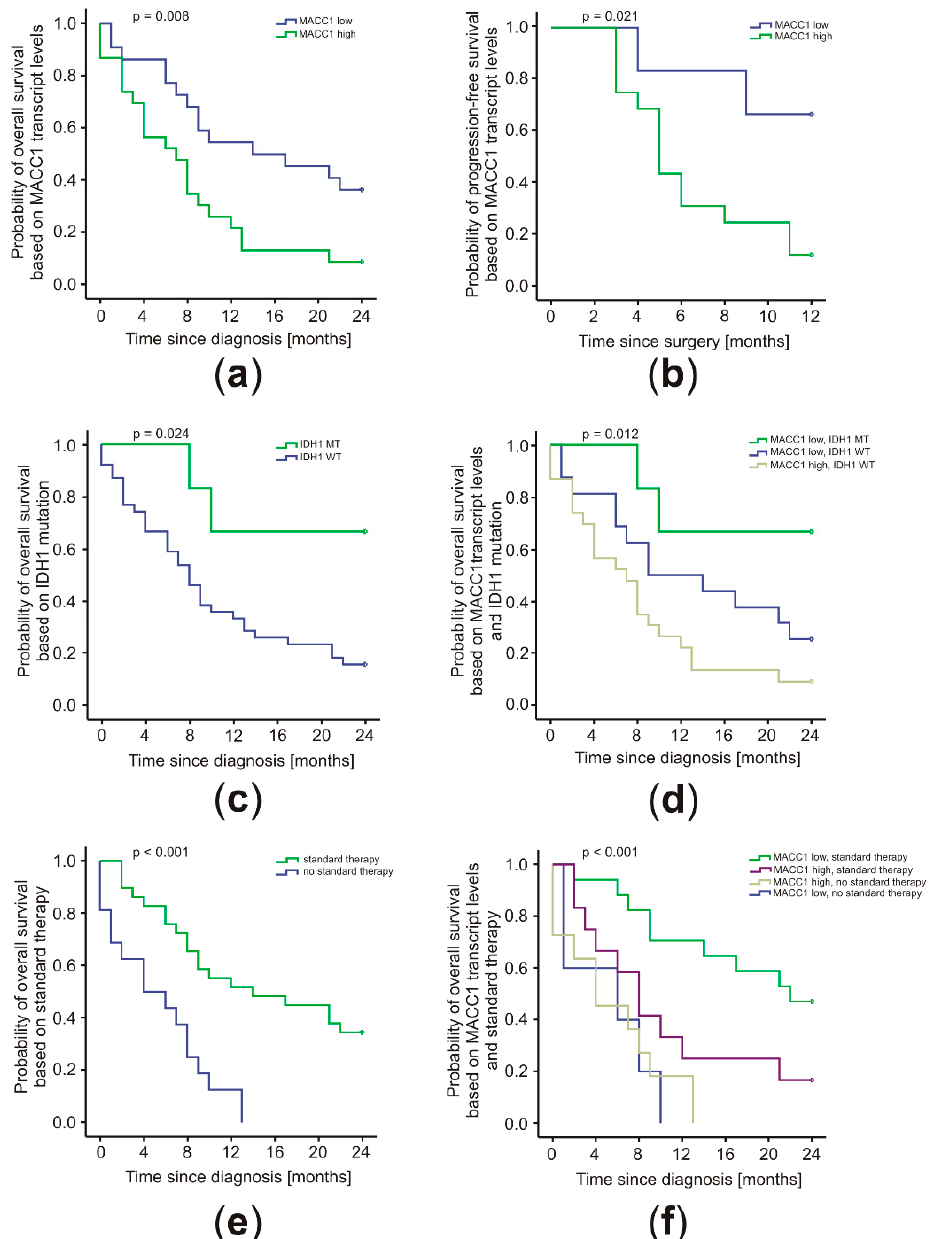
Figure 2. MACC1 levels correlated with patient prognosis conjoined with the IDH1 mutation status and treatment regimen. The cut-off values to distinguish low and high plasma levels of MACC1 were determined by receiver–operator characteristics (ROC) analyses and patient survival was visualized by Kaplan–Meier plots. ( a ) 24 months OS, cut-off = 0.384% calibrator; MACC1 low n = 22; MACC1 high n = 23) and ( b ) 12 months progression-free survival (PFS) (cut-off = 0.216% calibrator; MACC1 low n = 7; MACC1 high n = 15) of all GBM patients. ( c ) 24 months OS of GBM patients based on the status of IDH1 R132H mutation (IDH1 MT n = 5; IDH1 WT n = 36) in the tumor and ( d ) in combination with MACC1 transcript level (MACC1 low, IDH1 MT n = 5; MACC1 low, IDH1 WT n = 14; MACC1 high, IDH1 WT n = 17). ( e ) 24-month OS of patients receiving the standard therapy regimen (operation and radiochemotherapy according to Stupp [1]) compared to the OS of patients without standard therapy treatment (standard therapy n = 29; no standard therapy n = 16) and ( f ) in combination with the MACC1 level (MACC1 low, standard therapy n = 17; MACC1 high, standard therapy n = 12; MACC1 low, no standard therapy n = 5; MACC1 high, no standard therapy n = 11). Statistical analysis of patient survival was performed via log-rank